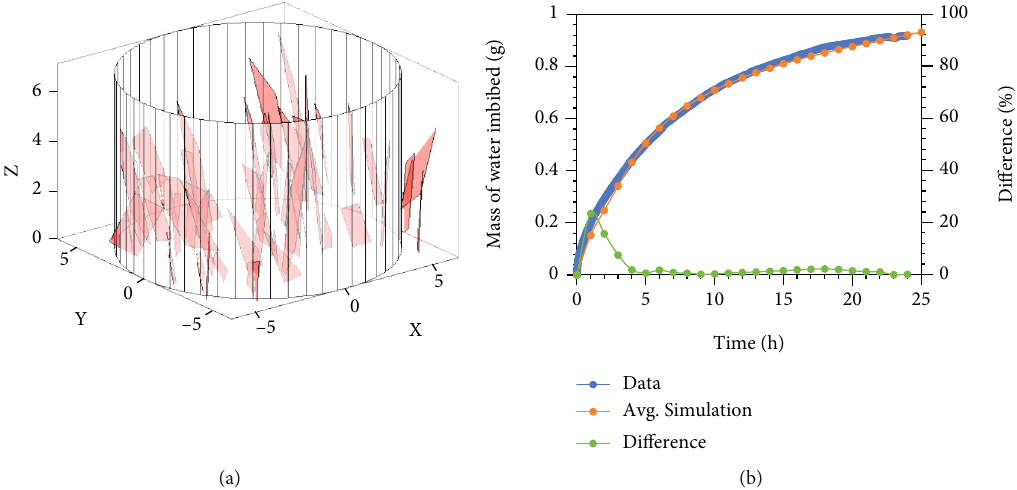
Figure 10: (a) Sketch of virtual P -direction fractures generated by the WPM model for a cylindrical Barnett sample. (b) Comparison of imbibition data vs. simulation results for P -direction